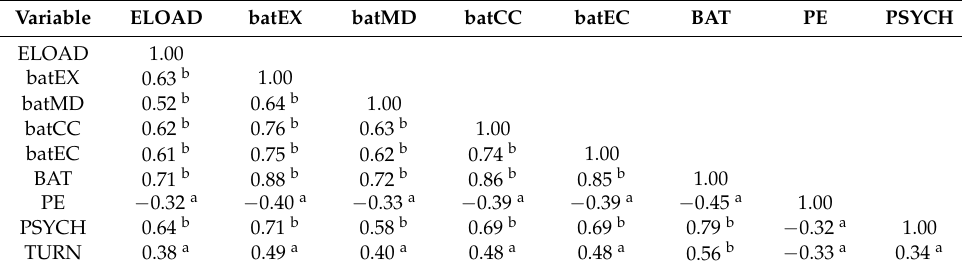
Table 2. Correlation matrix for the latent